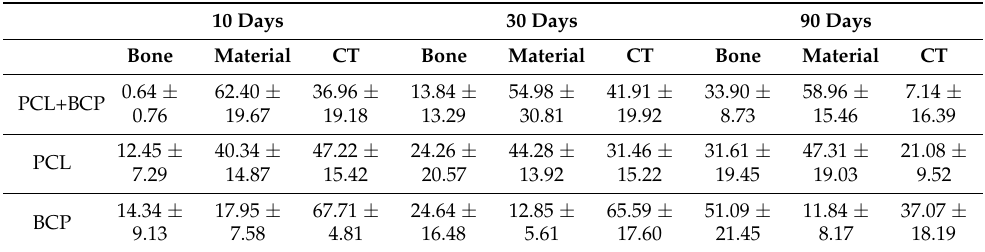
Table 4. Results of the histomorphometrical tissue distribution measurements (in percent).